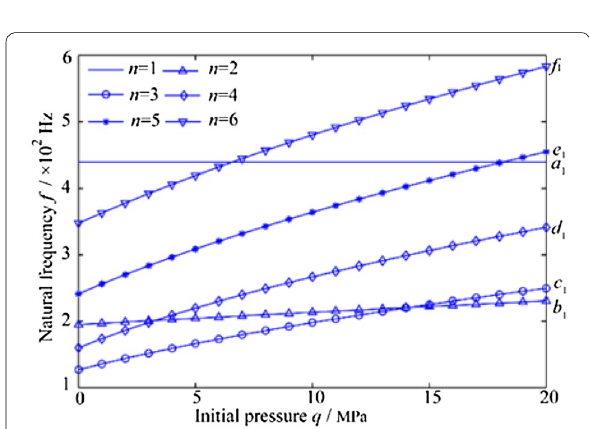
Figure 7 Variation of the natural frequency against q for several special values of n